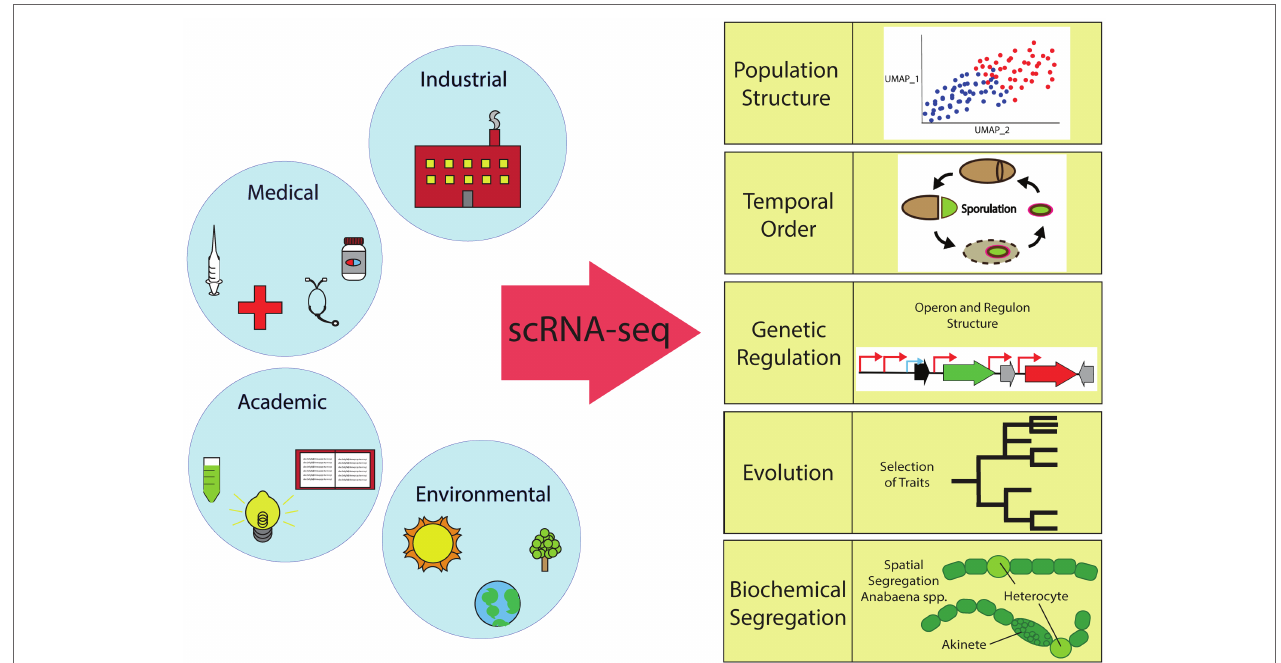
FIGURE 2 | Overview of the scientific fields impacted by bacterial single-cell RNA sequencing. scRNA-seq can elucidate bacterial population structure (TSNE or UMAP plots), temporal order (sporulation cycle, etc.), genetic regulation (activation/repression), evolution (selection of traits), or biochemical segregation (spatial or